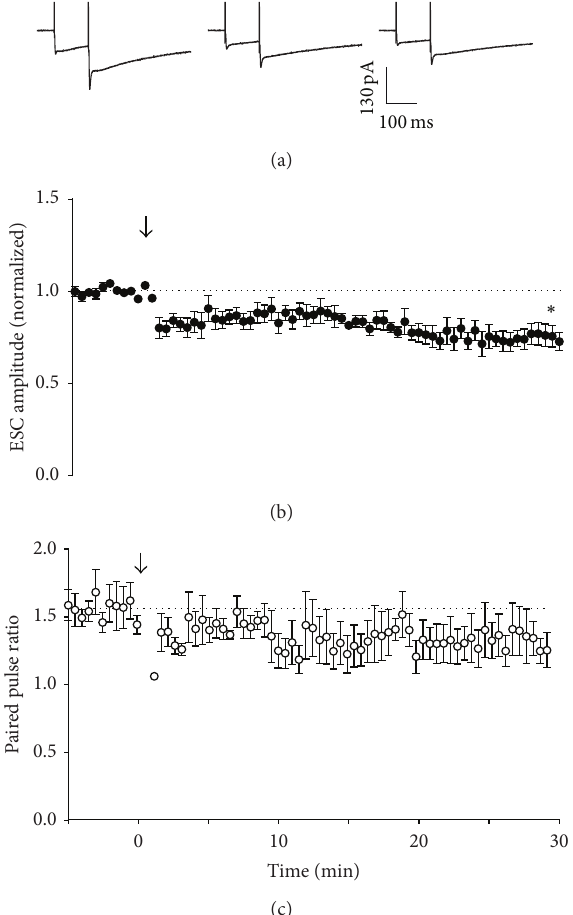
Figure 2: Effect of 16Hz tetanic stimulation on Bergmann glial responses. (a) Representative whole-cell recordings of glial extrasy- naptic currents (ESC) generated by paired pulse stimulation (100ms interval) of parallel fibres in transverse cerebellar slices at 0.033 Hz before (first panel), immediately after (second panel), and 30 minutes after (third panel) RFS. (b) Time course of RFS effect on amplitude of the first pulse in each pair, with RFS delivered at 𝑡 = 0 , indicated by the arrow. Data are mean ± s.e.m. from 6 cells. ∗ 𝑃 = 0.0177 , one-sample 𝑡 -test. (c) Time course of RFS effect on paired pulse ratio after tetanic stimulation at 𝑡 = 0 . Data are mean ± s.e.m. from 6 cells.